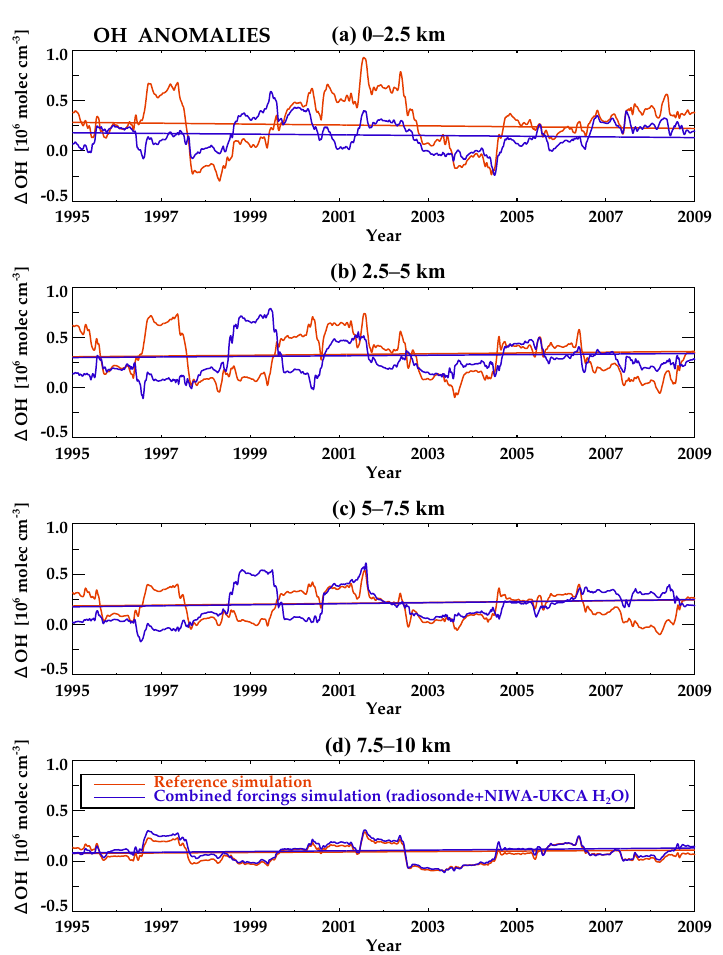
Figure 10. Variability and trends of the OH anomalies at different altitudes: (a) 0–2.5, (b) 2.5–5, (c) 5–7.5, and (d) 7.5–10km. The red solid line is the time series of the reference simulation and the blue solid line is the combined forcings simulation considering radiosonde – NIWA–UKCA H 2 O.